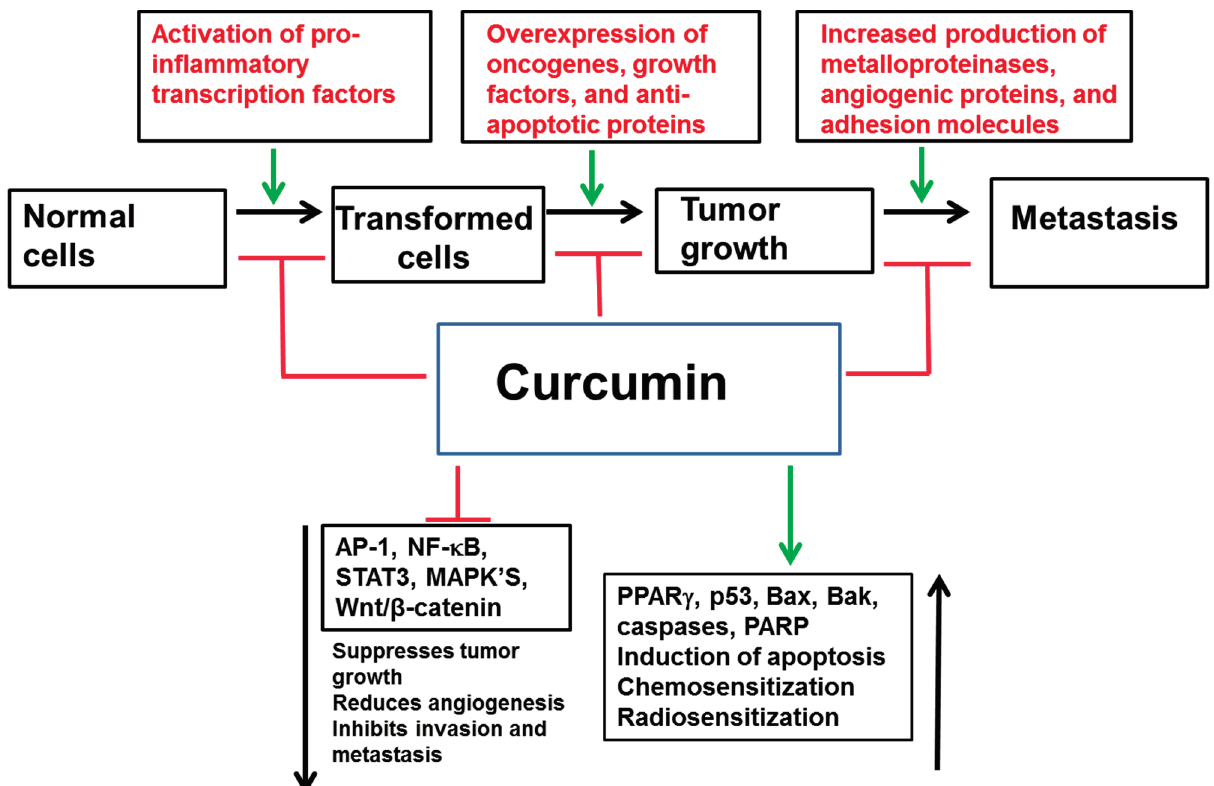
Figure 3. Potential anti-cancer functions of